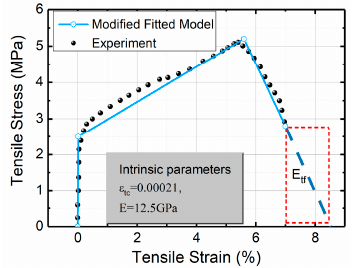
Figure 11. The fitted tension model of the SHCC used in this simulation.